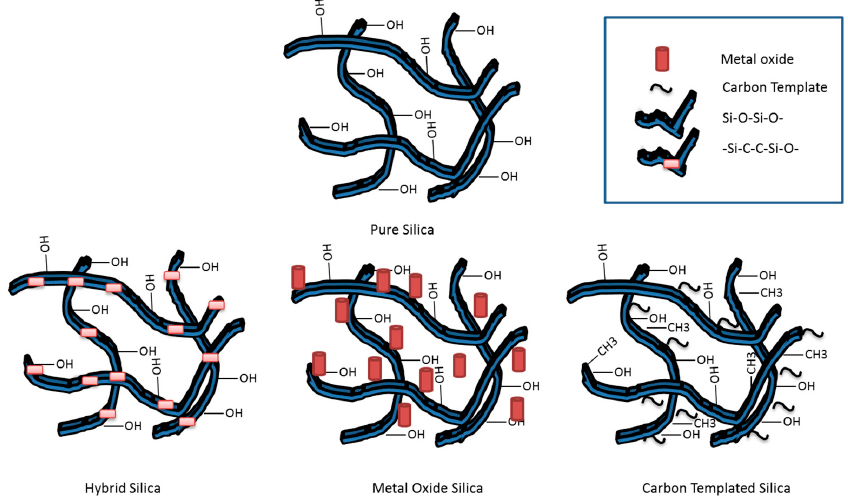
Figure 10. Schematic representation of different approaches for silica modification.